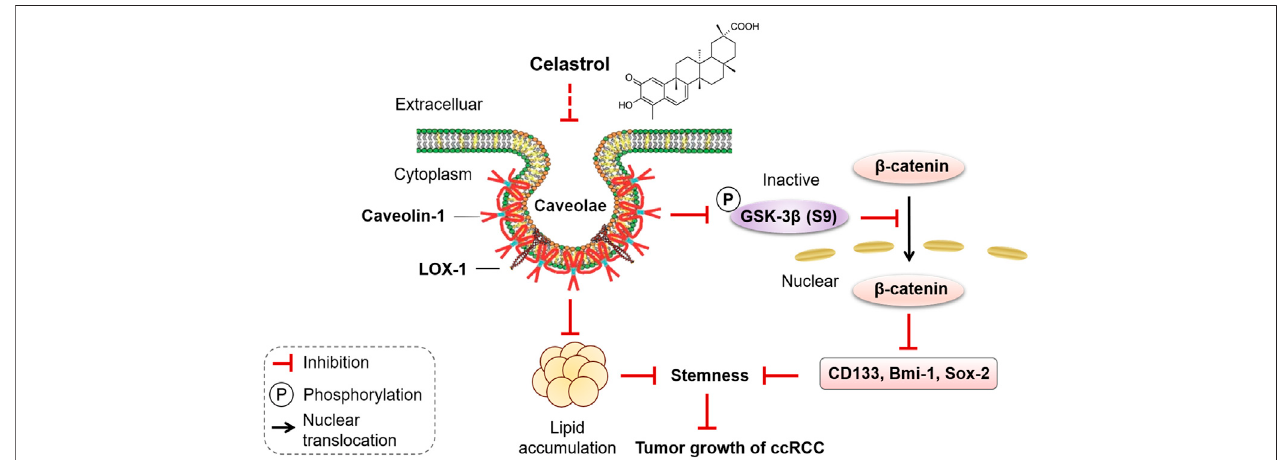
FIGURE8| Diagram summarizedthe effect ofcelastrolon lipid accumulationand stemnessin ccRCC progression.Celastrol, asan active compound oftraditional Chinese medicine, inhibited the binding of CAV-1 and LOX-1, reduced lipid accumulation, blocked the phosphorylation of GSK-3 β at Ser9, prevented nuclear translocation of β -catenin, thereby impairing stem-like properties, eventually inhibited tumor growth of ccRCC.